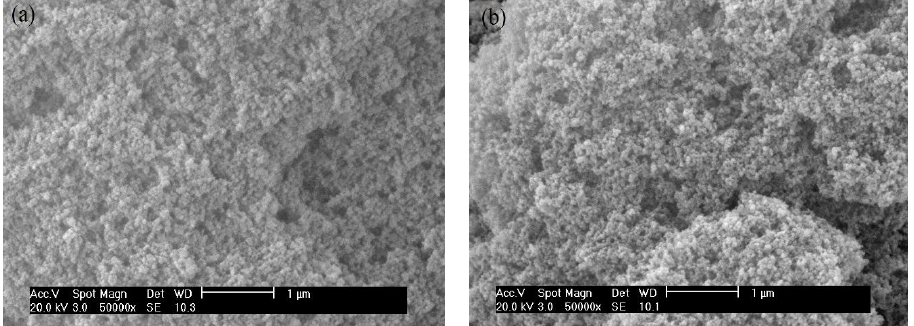
Figure 3. Scanning electron microscope (SEM) images of silica nanoparticles coating before ( a ) and after surface treatment ( b ).